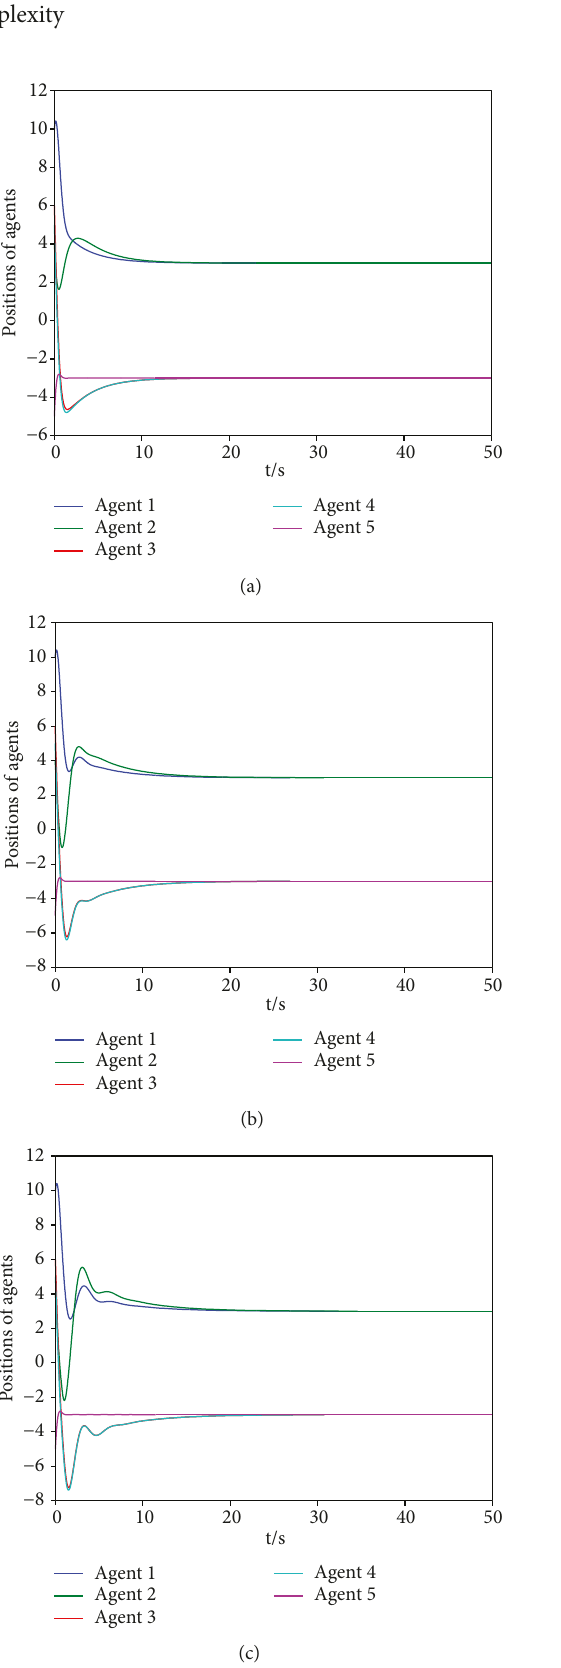
Figure 7: The agents ’ position trajectories, where τ = 0 15 . (a) τ = 0 , (b) τ ij